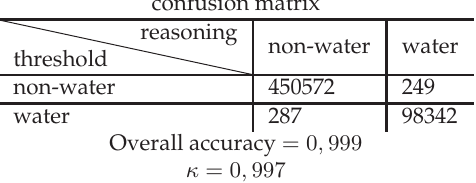
Table 3: Evaluation of ontological classification approach: confusion matrix comparing reasoning to threshold for water